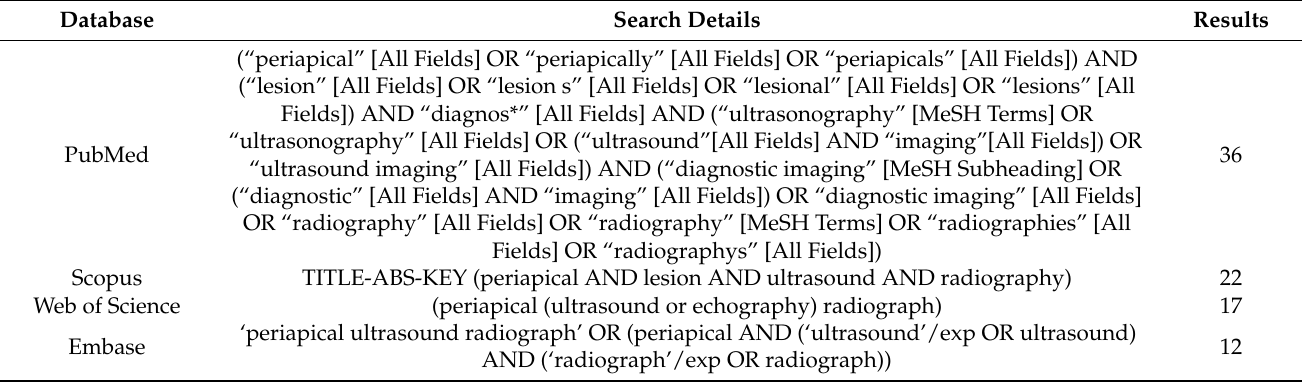
Table 1. Search queries used in different